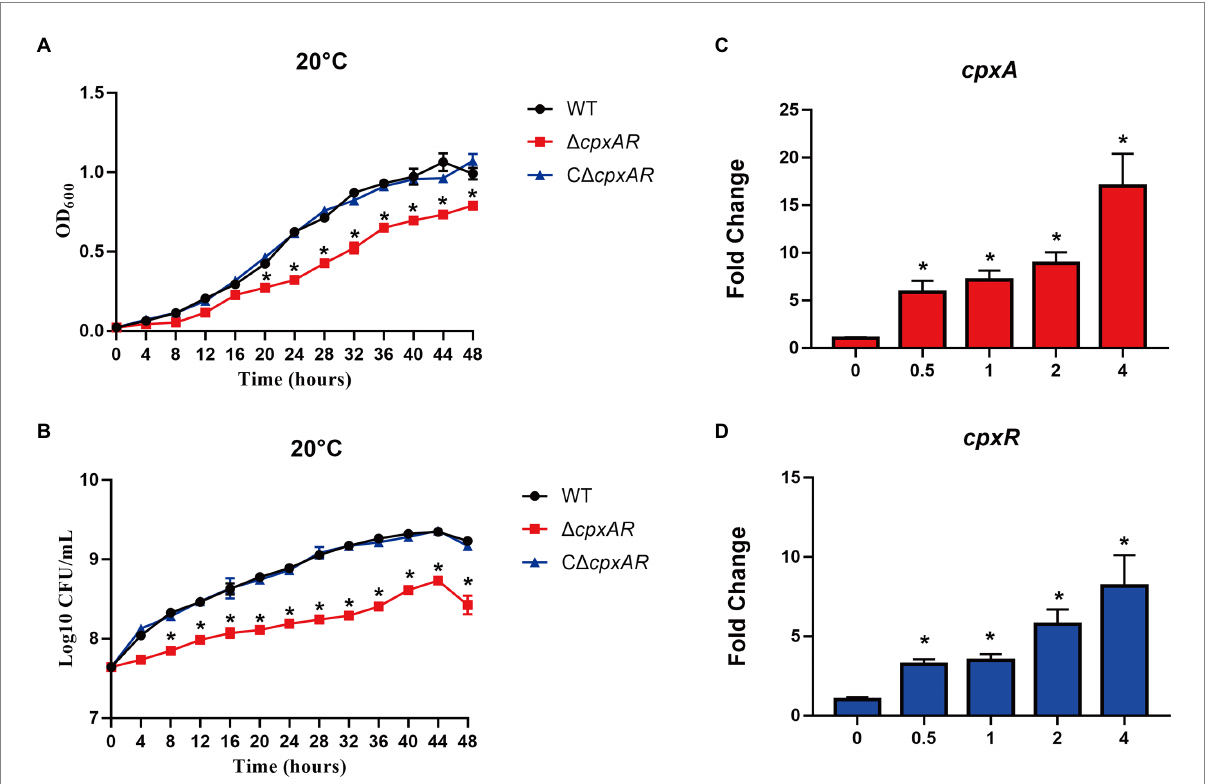
FIGURE 1 CpxA/CpxR is required for APP cold growth. The growth rates of the WT, ∆ cpxAR and C ∆ cpxAR strains at 20 ° C were monitored by measurement of OD600 (A) and viable cell counts (B) . qRT-PCR analysis of cpxA (C) and cpxR (D) genes in A. pleuropneumoniae S4074 under 20 ° C. * p <